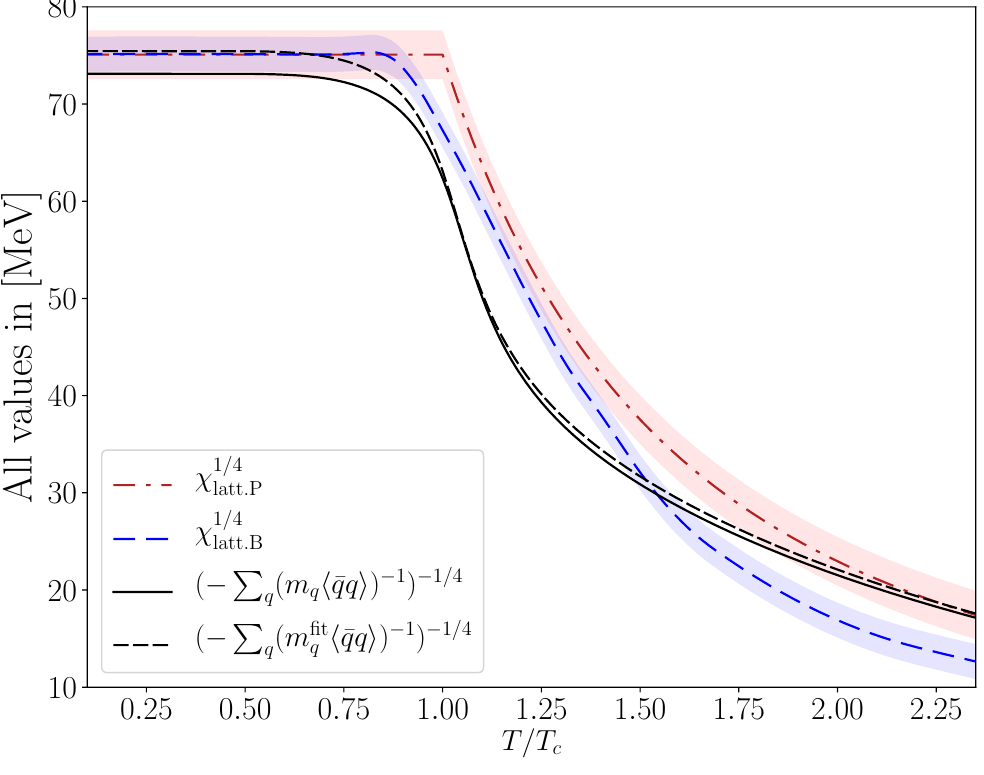
Figure 6. The short-dashed black curve shows the non-isosymmetric case of the leading term of = m fit / 0.48 = 9.71 MeV, and appropriately χ ( T ) 1 / 4 , Equation (9), with m fit u = 4.66 MeV and m fit u d recalculated condensates ⟨ ¯ uu ⟩( T ) and ⟨ ¯ dd ⟩( T ) . The vertical scale is zoomed with respect to Figure 5 to help resolve the short-dashed curve from the solid curve representing again the isosymmetric case of the same separable rank-2 model. Also, the lattice results [70,71] are again depicted as in Figure